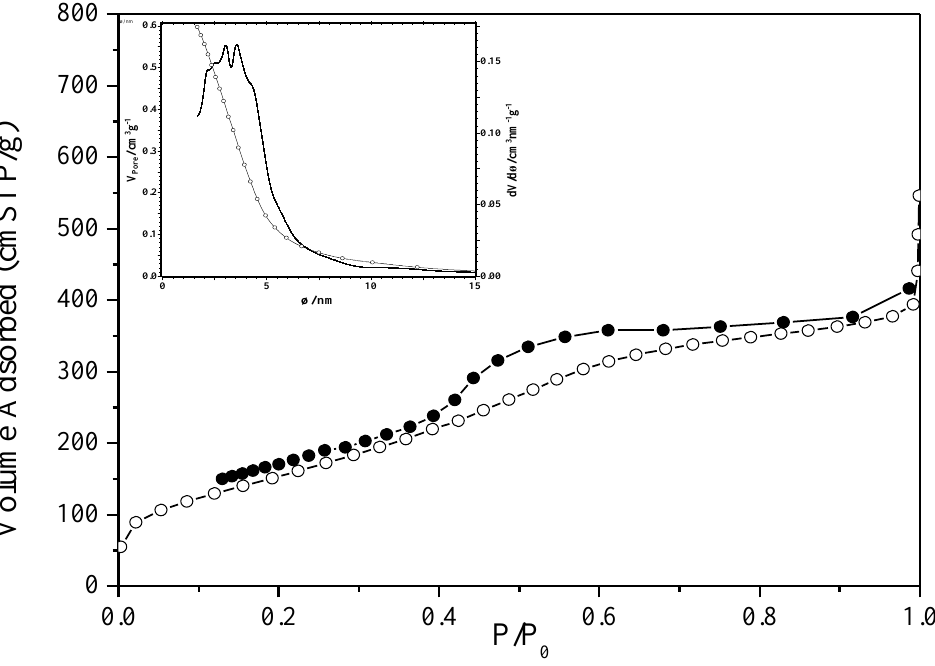
Figure 11. Nitrogen adsorption-desorption (○ and ●, respectively) isotherms of the ordered mesoporous SiBCN material. The pore size distribution curves are shown